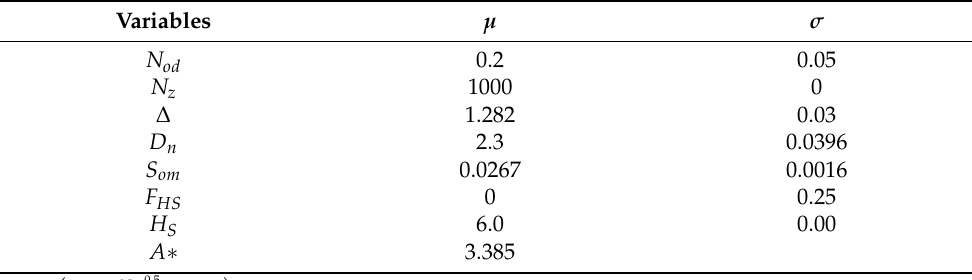
Table 2. List of values of two parameters of Weibull distribution suggested by PIANC [18]. E [ H ST